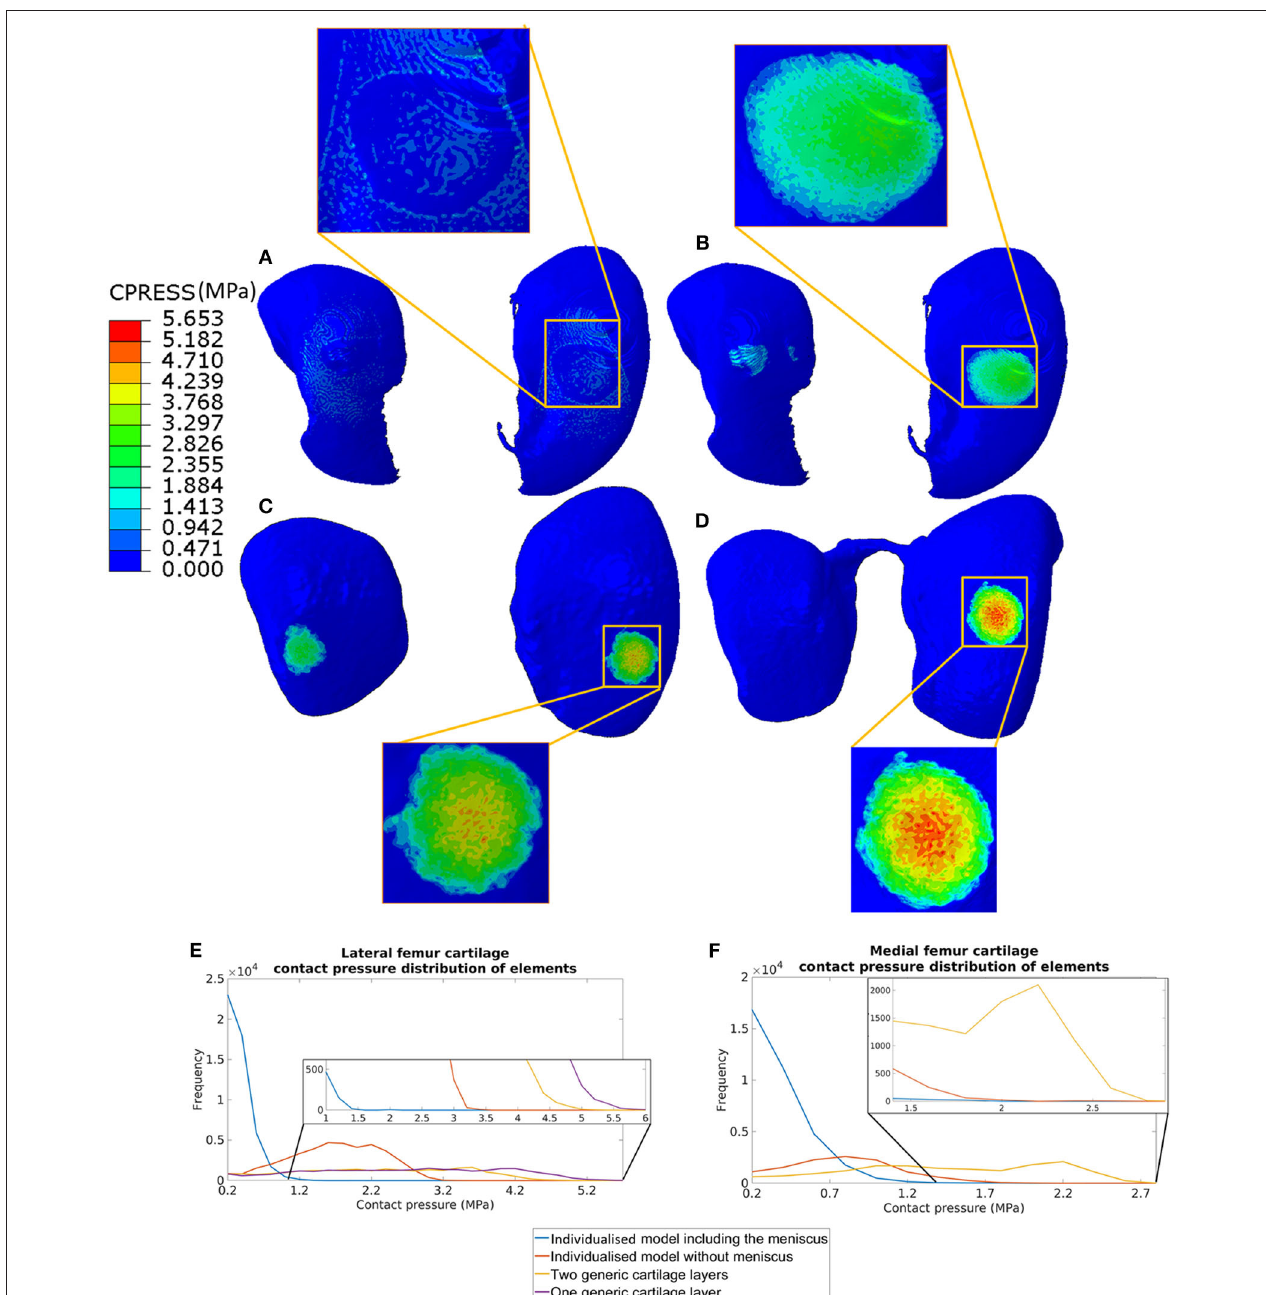
FIGURE 3 | Contact pressure distribution in the femoral cartilage for the four models at 0.3N reaction force: (A) model including individual cartilage layers with meniscus; (B) model including individual cartilage layers without meniscus; (C) model including homogeneous cartilage layers with different thickness values for the lateral and medial condyles; (D) model including homogeneous cartilage layer with the same value of thickness for both condyles. The distribution of contract pressure for lateral (E) and medial (F) condyle cartilages are reported. The contact pressure for medial femur cartilage in the model with homogeneous cartilage layer with the same thickness is zero as there are no contacts between the cartilage of the femur and of the